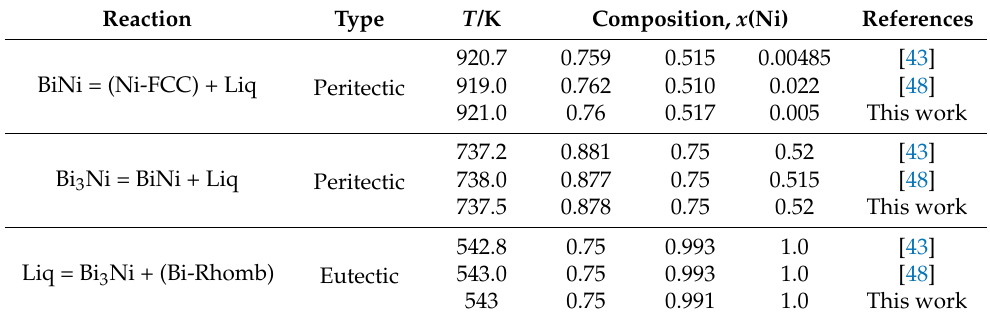
Table 3. Comparisons of invariants in Bi-Ni system.